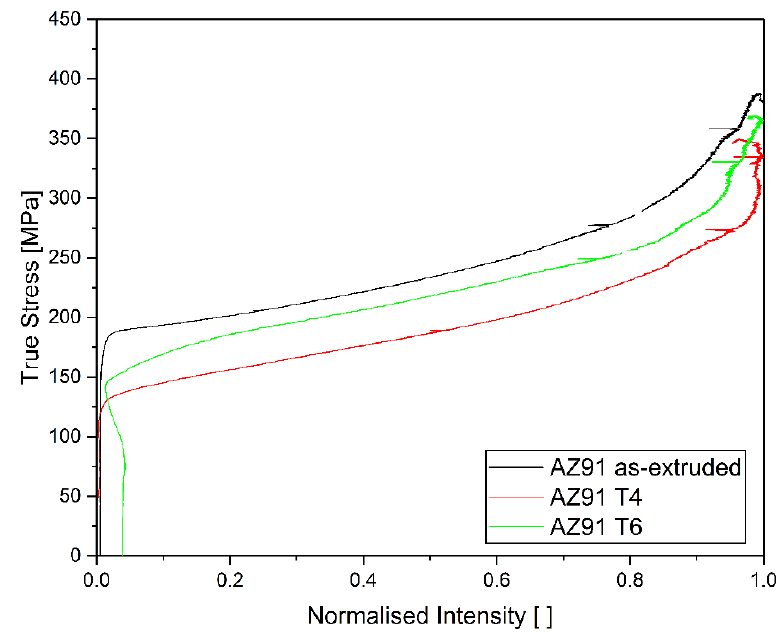
Figure 7. True stress against normalised intensity of the {00.2} planes for unreinforced AZ91.